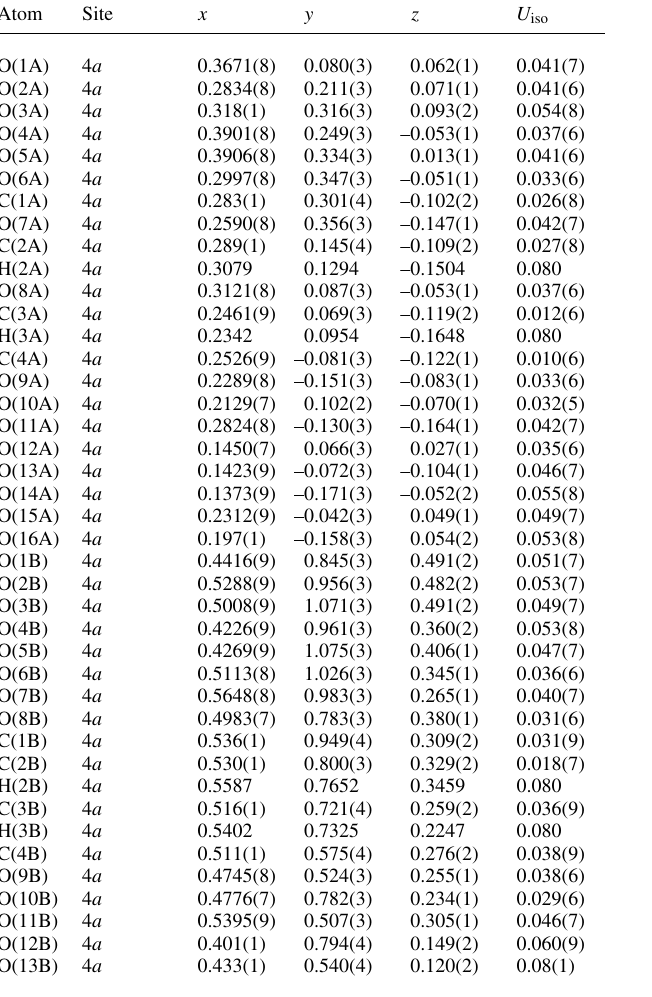
Table 2. Atomic coordinates and displacement parameters (in Å 2 ) .